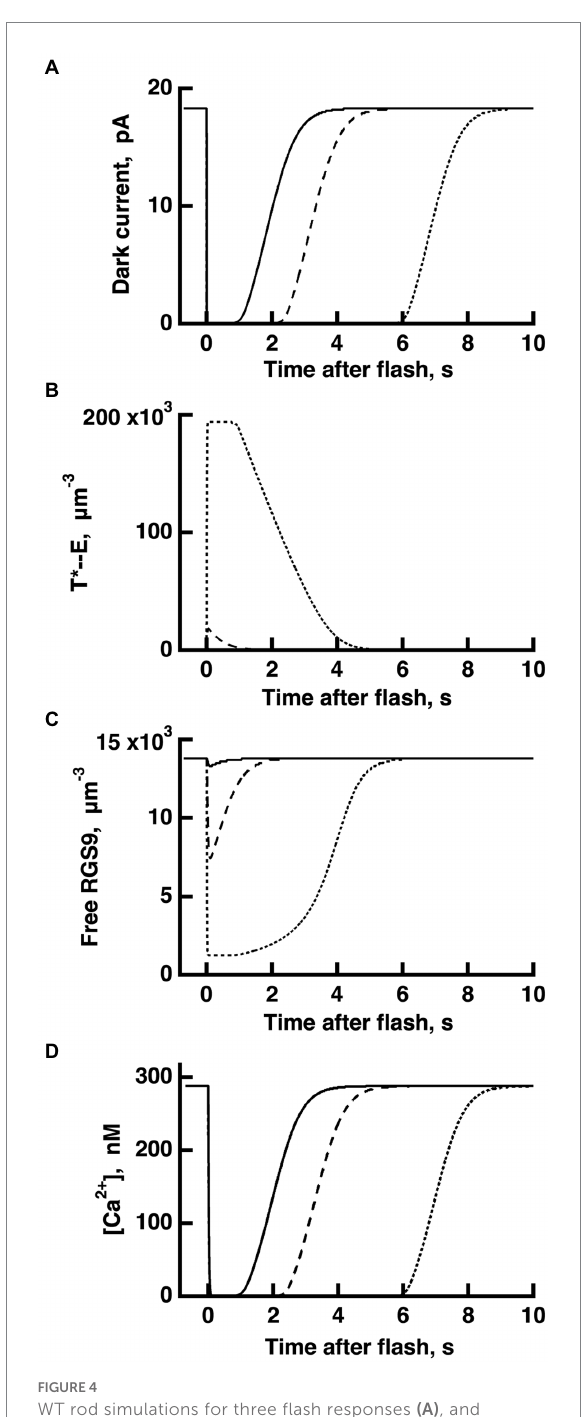
FIGURE 4 WT rod simulations for three flash responses (A) , and the associated dynamics for T * ——E (B) , free RGS9 (C) and Ca 2+ (D) . The flash was given at time zero. The three flashes elicited responses with T sat values in the initial, linear segment of the Pepperberg plot, near the transition to the upward bend, and well within the upward bend, respectively ( cf. Figure 3): Ln ( Φ ) = 8 (continuous lines), Ln ( Φ ) = 11 (dashed lines), Ln ( Φ ) = 14 (dotted lines). Dynamics of free RGS9 deviated markedly from that of T * ——E, and greatly prolonged T sat for the response to the brightest